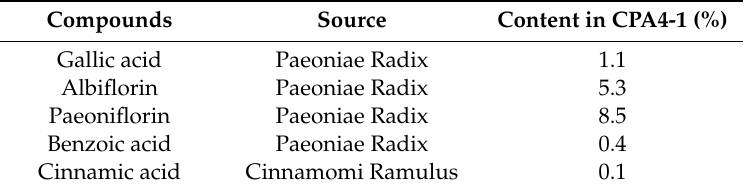
Table 2. Content of the five compounds in CPA4-1 as determined by HPLC analysis. Compounds